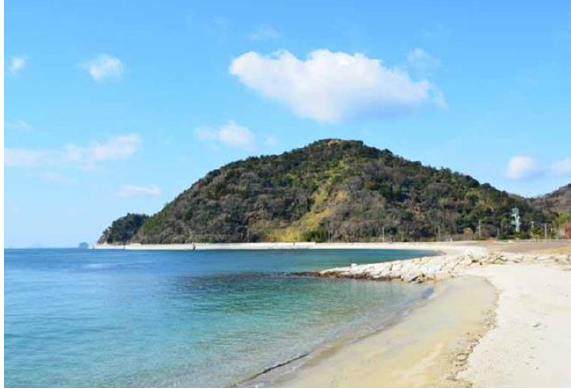
Figure 4. Nakajima Island in Ehime prefecture, Japan [21].